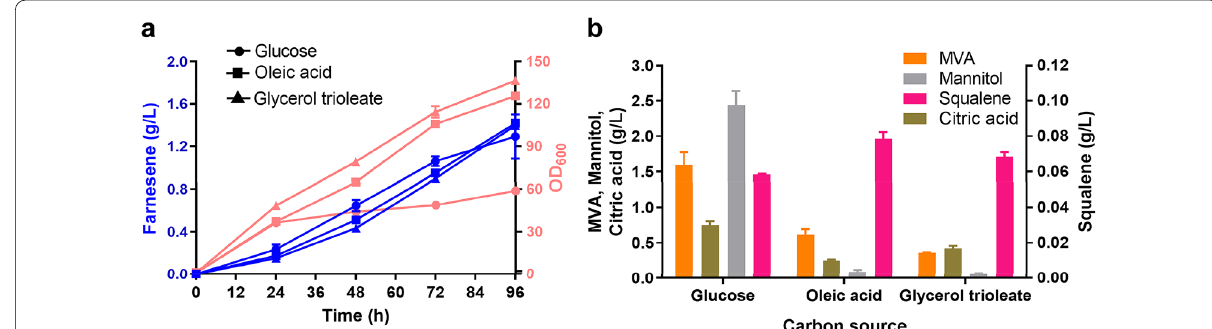
Fig. 2 OD 600 , α-farnesene, and other metabolites production on different substrates by the F5 strain. a α-Farnesene and OD 600 accumulation curve during fermentation. b Citric acid, mannitol, squalene and mevalonate accumulation. The metabolites were detected at 96 h fermentation in